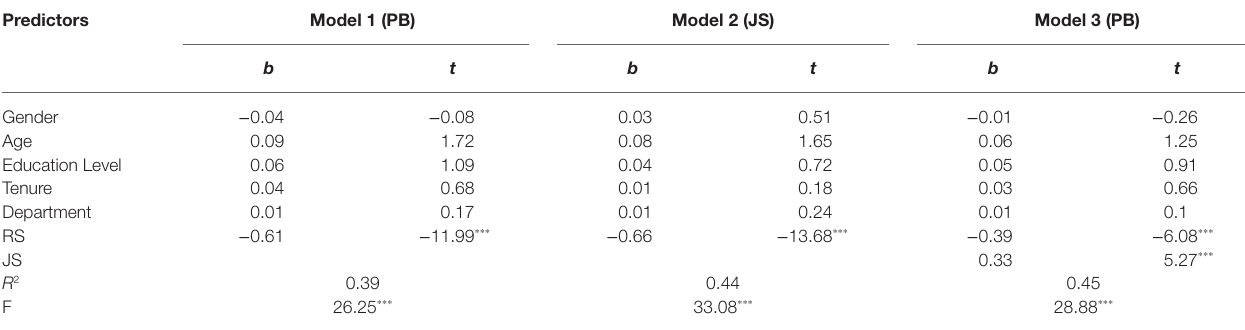
TABLE 4 | Mediation effect of job satisfaction.